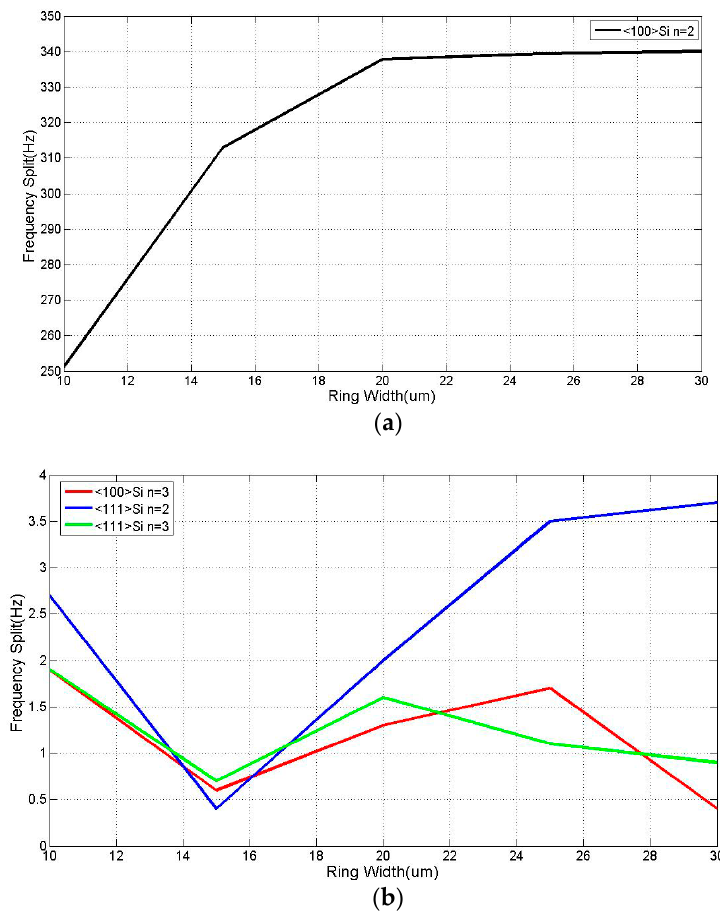
Figure 6. Relationship between the frequency splits and ring width ( a ) DRG made by <100> silicon and work in n = 2 mode, ( b ) DRG made by <100> silicon and work in n = 3 mode; <111> silicon, work in n = 2 and n = 3 mode.